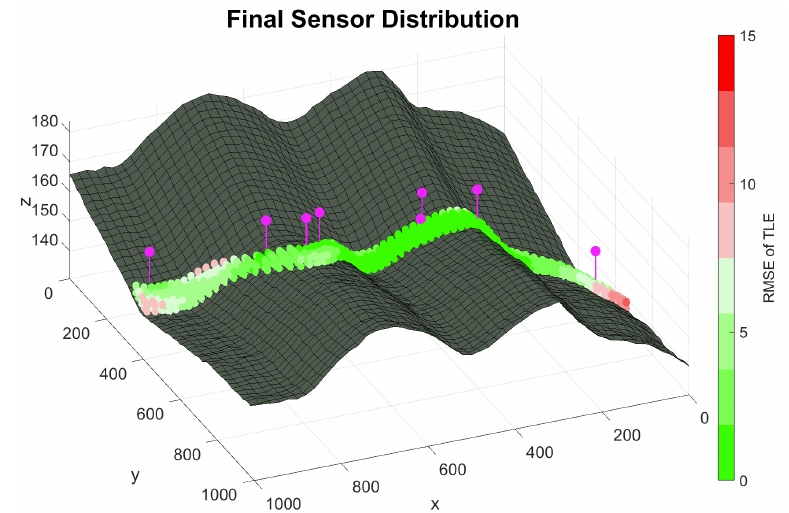
Figure 9. Optimal node distribution of 8 sensors obtained by the Hybrid Memetic Algorithm (HMA) and the RMSE accuracy of the TLE for the scenario proposed. The obtained distribution achieves an overall adequate positioning against the terrain adversities, even so for a reduced number of